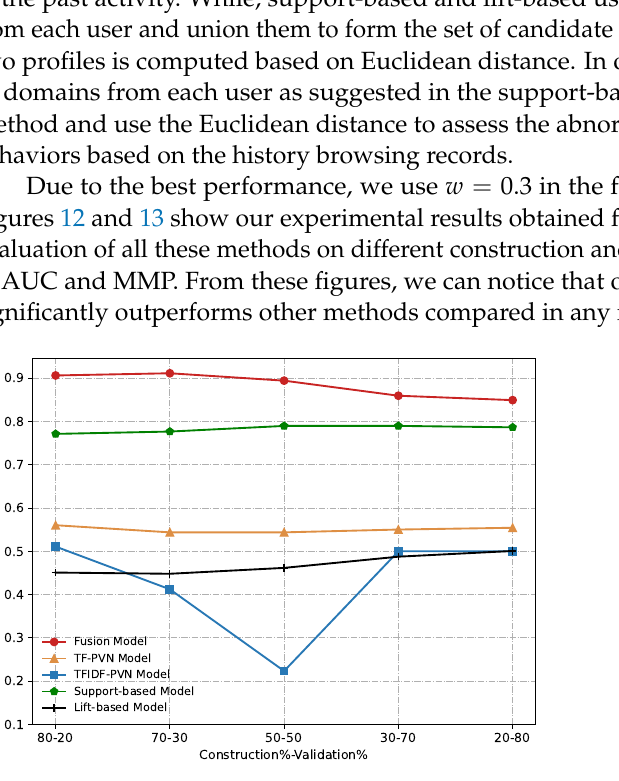
Figure 12. Comparative results of the Fusion model, TF-PVN model, TFIDF-PVN model, Support- based model and Lift-based model in terms of